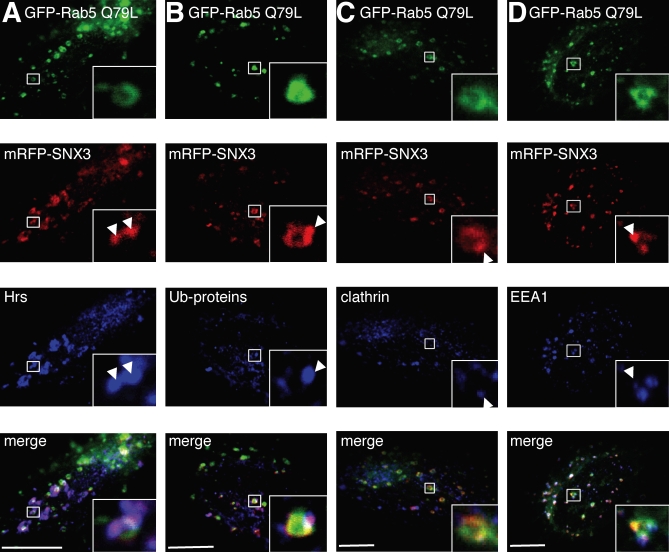
SNX3 Colocalizes with Hrs, Ubiquitinated Proteins, and Clathrin on Rab5Q79L Enlarged Endosomes.(A–D) HeLa cells co-expressing both GFP-Rab5Q79L and mRFP-SNX3 were processed for immunofluorescence using different antibodies as indicated and analyzed by triple channel fluorescence. Arrowheads point at regions containing GFP-SNX3. Scale bar indicates 10 μm. Insets in the lower right are a magnification of the regions shown in the boxes.